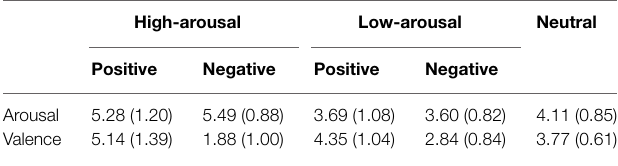
TABLE 1 | Means (SD) of the ratings for each